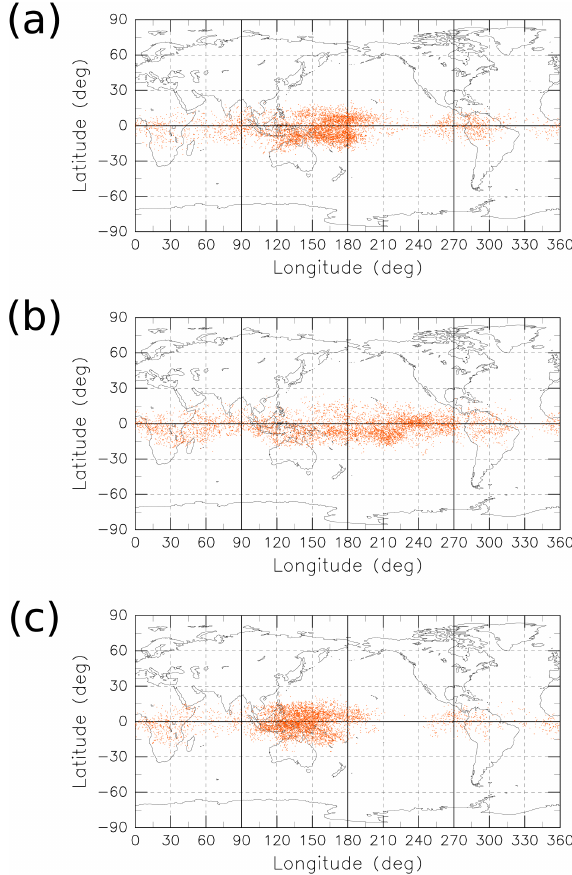
Figure 8. Horizontal distribution of LCP taken by all TST trajec- tories initialized at 400K isentrope in February (a) 1997, (b) 1998, and (c)